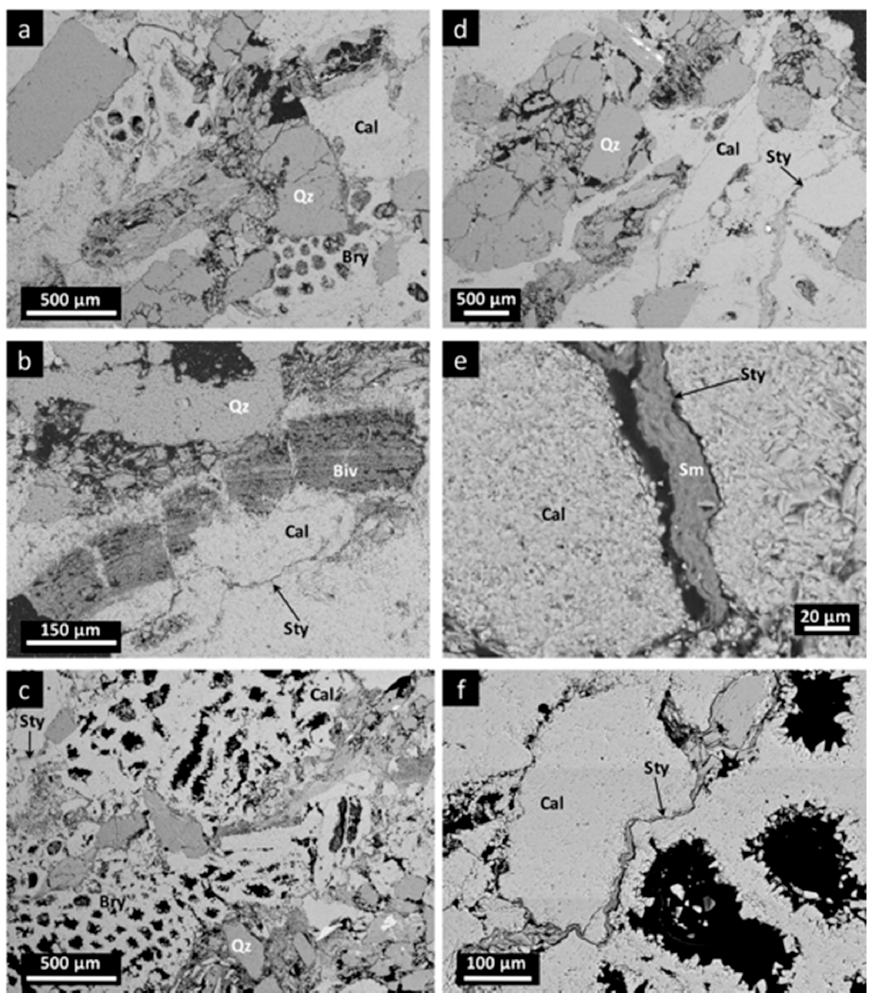
Figure 17. BSE images from samples in the damage zones in the Tablate A locality (S of the Padul Fault). ( a – c ) Carbonate lithofacies containing carbonate skeletal bioclasts (bryozoan fragments, a and c, and bivalve fragments, b) and terrigenous grains (quartz and schists). ( d – f ) Thin discontinuous stylolitic surfaces formed by an ultrafine smectite matrix that encloses relic detrital grains of illite and quartz. Sm: Smectite, Sty: Stylolitic surfaces, Bry: Bryozoan fragments, Biv: Bivalve fragments. Rest of abbreviations as in Figure 13.